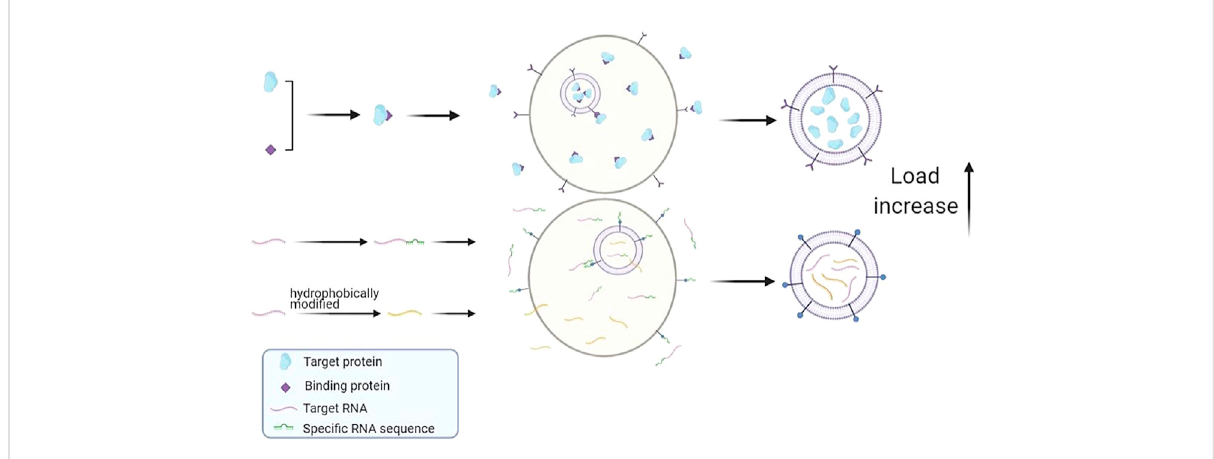
FIGURE 3 Schematicsummaryofimprovedendogenousdrugloadingmethod.Proteindrugs canbefusedwithspecial bindingproteins andanchoredon membrane proteins to improve drug loading. Special gene sequences can be added to RNA drugs, and the loading ef fi ciency of drugs can be improved by interacting with corresponding RNA binding proteins. Or change the hydrophobicity of RNA drugs and increase the amount of RNA entering